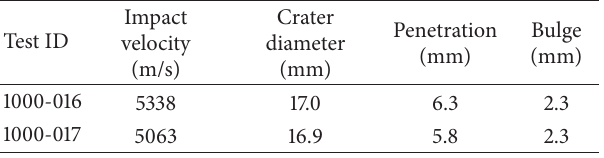
Table 1: Physical dimensions of the crater and bulge after impact.